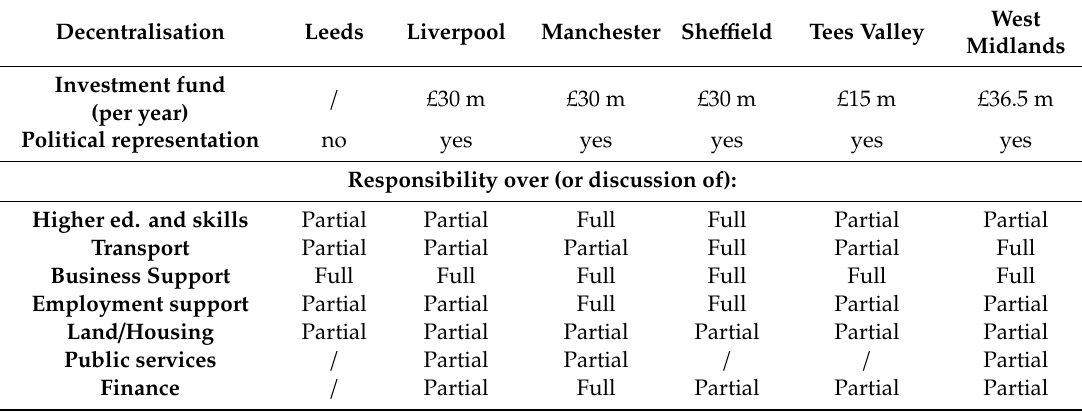
Table 1. Level of policy, financial, and political decentralisation in six English city